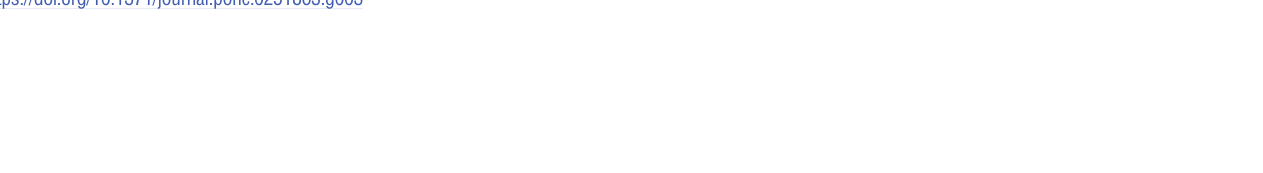
PLOS ONE | https://doi.org/10.1371/journal.pone.0251863 May 17,